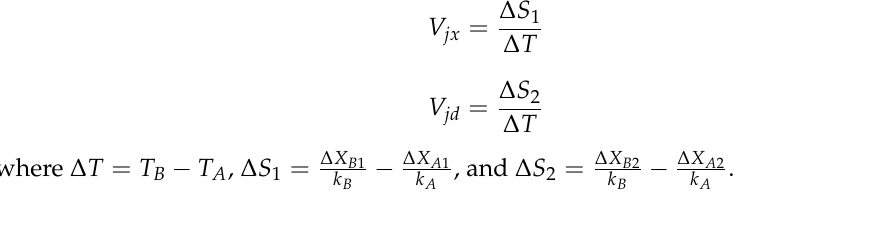
Figure 19. X-ray test results.